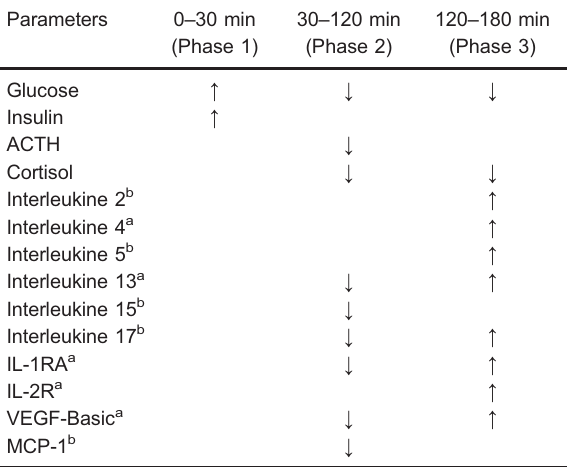
Table 3 . Variation of blood levels of cytokines during an oral glucose tolerance test.